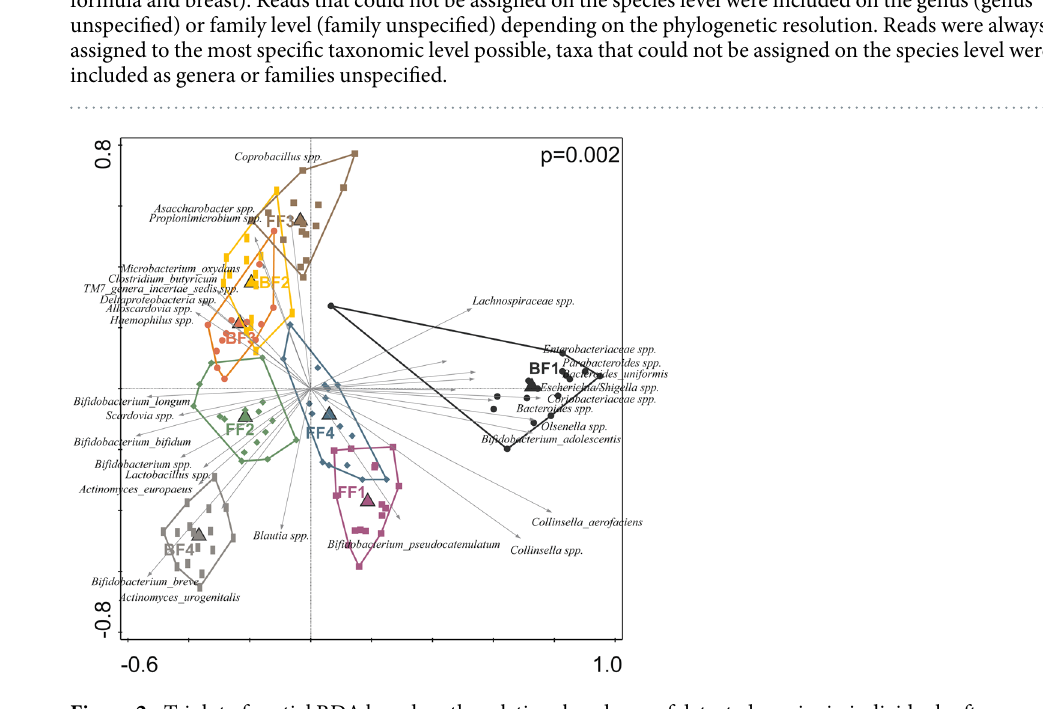
Figure 2. Triplot of partial RDA based on the relative abundance of detected species in individuals after removing the effects of time and type of feeding. Constrained explanatory variables are indicated by triangles: BF1-4 represents infants being breastfed and FF1-4 represents infants being formula-fed. The arrows indicate the 30 species which had the highest amount of variability in their values explained by the canonical axes. Upper right shows the P-value of Monte Carlo Permutation testing. Covariates time and feeding were first fitted by regression and then partialled out (removed) from the ordination. Taxa that could not be assigned on the species level were included as genera or families